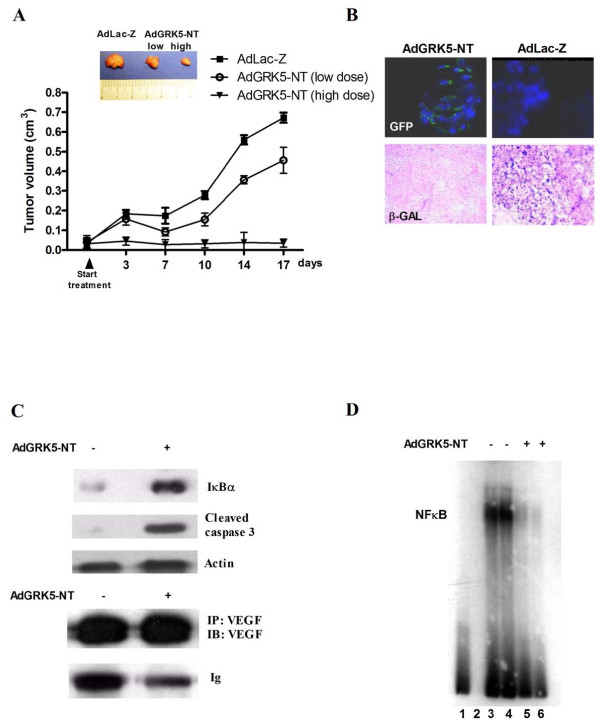
Effects of GRK5-RH in vivo on tumor growth and biochemical analysis: treatment with adenovirus. A) To validate our in vitro results, we studied the effects of adenoviral mediated overexpression of GRK5-RH in a cancer model in vivo. Tumor growth was measured twice a week by a caliper during all the treatment long (17 days of treatment). Low doses (108 pfu/ml in 200 ul) of AdGRK5-NT retard tumor growth compared to controls. High doses (1011 pfu/ml in 200 μl) are more effective, inducing a complete inhibition of tumor growth. Figure also shows a representative image of tumors at the end of the treatment. B) 17 days from starting treatment, mice were sacrified and tumors were taken for histological analysis. To ascertain GRK5-RH expression, cryostat sections were analyzed by direct observation of the green light at the fluorescence microscope. LAC-Z expression in control tumors was evaluated by X-GAL staining at direct light (blue staining indicates LAC-Z expression; eosin was used for counterstaining in red). C) Tumors were homogenized to analyze IκBα levels, VEGF production and apoptosis. Adenoviral mediated overexpression of GRK5-RH induces an increase of IκBα and cleaved caspase 3 levels and a reduction of VEGF expression in treated tumors compared to controls treated with AdLac-Z. D) Nuclear extracts from tumors were analyzed by EMSA. AdGRK5-NT inhibits NFκB activity compared to controls. Lane 1 = probe alone; Lane 2 = empty; Lane 3-4 = AdLac-Z different treated tumors; Lane 5-6 = AdGRK5-NT treated tumors.